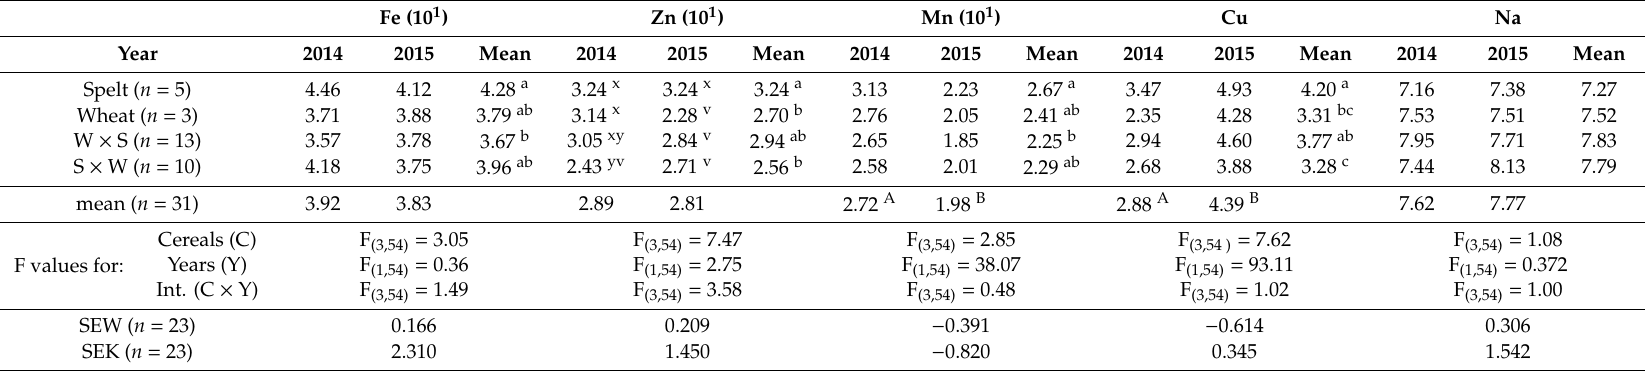
Table 5. Mean contents of the studied micro elements (mg kg − 1 ) in the grains of hybrids between bread wheat and spelt in relation to their parental forms. Fe (10 1 ) Spelt ( n =